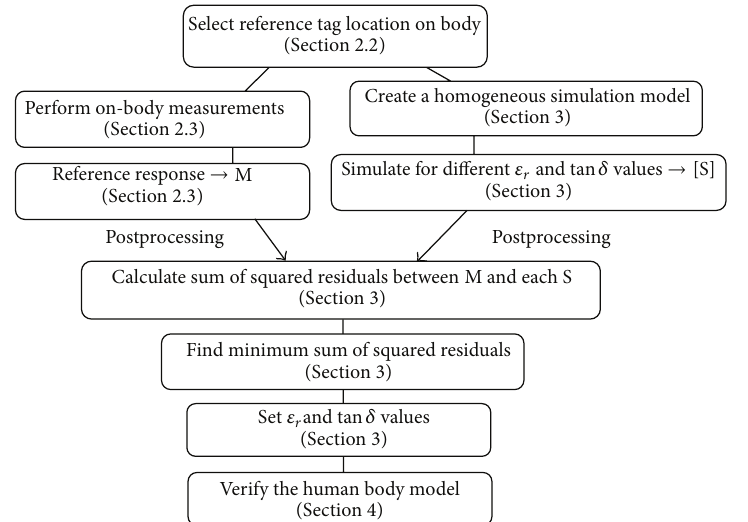
Figure 1: Flow chart for modeling the human body for RFID body-centric wireless systems. The human body model is developed using on-body measurements of a reference tag and electromagnetic simulations. The human body model electrical parameters 𝜀 𝑟 and tan 𝛿 are determined by calculating the sum of squared residuals between the measured reference response M and the simulated responses [S] attained for different 𝜀 𝑟 and tan 𝛿 values.